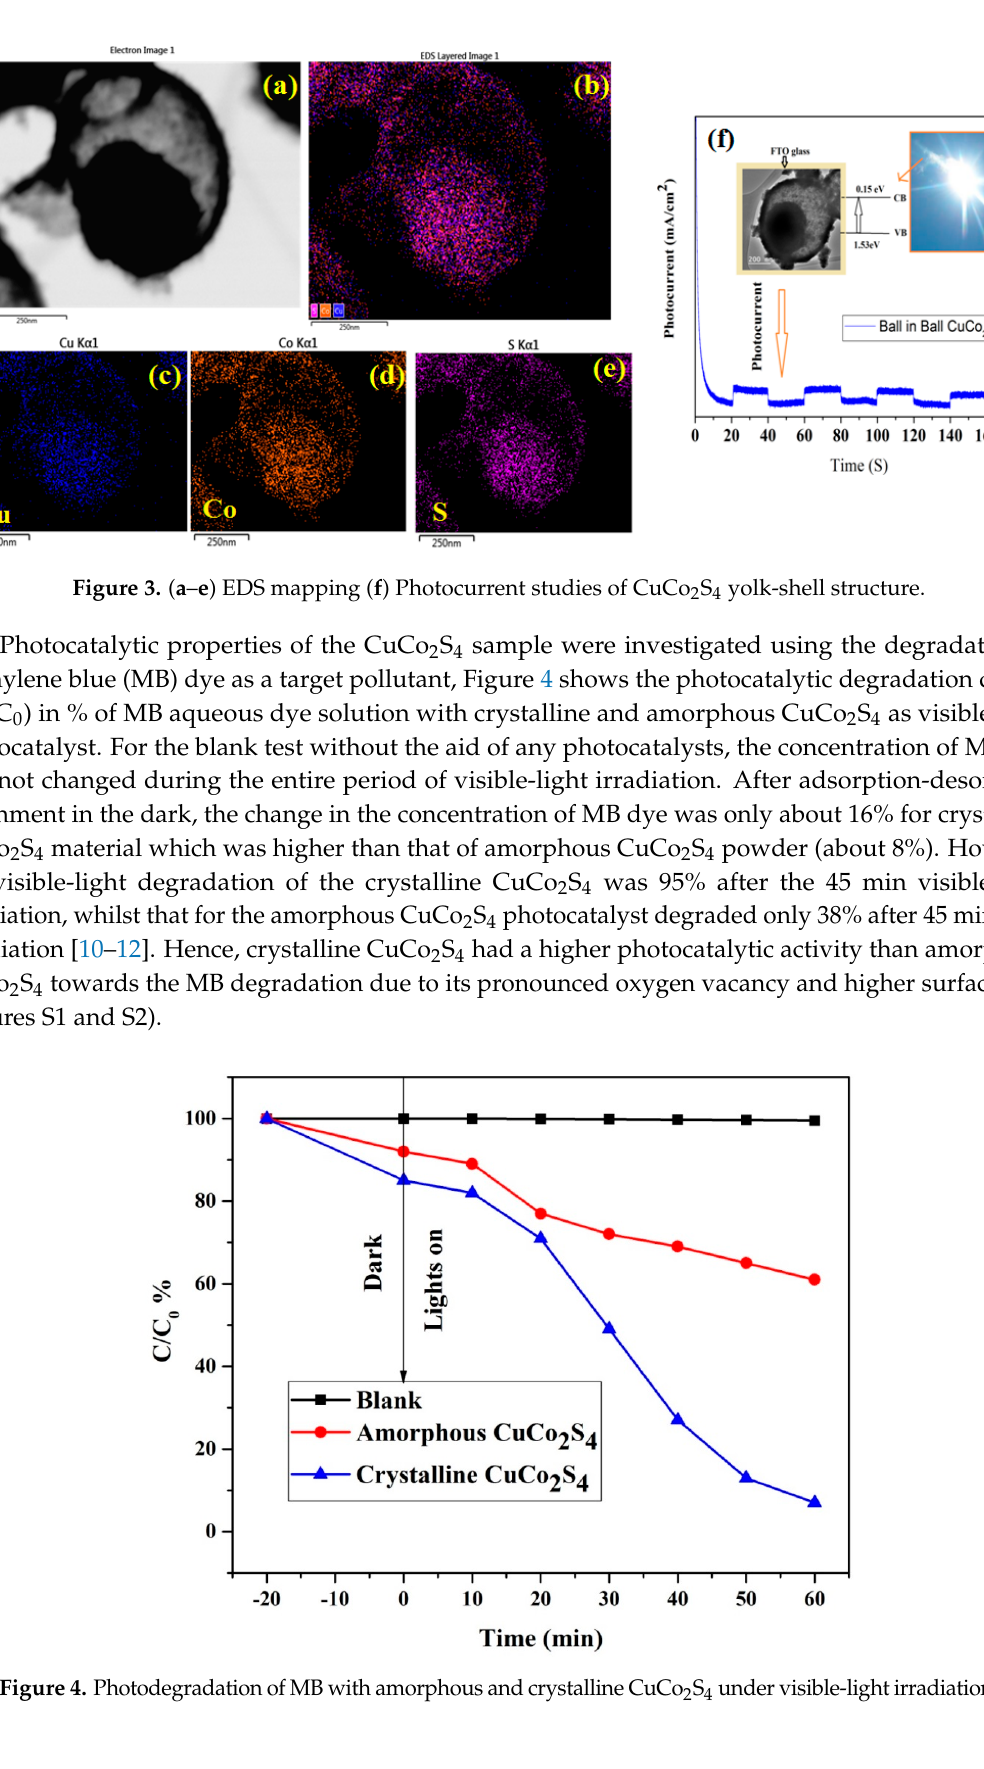
Figure 2. ( a ) Scanning electron microscopy (SEM) images ( b ) EDS spectra of CuCo 2 S 4 yolk-shell structure ( c ) Transmission electron microscopy (TEM) images of amorphous CuCo 2 S 4 ( d , e ) crystalline CuCo 2 S 4 yolk-shell.